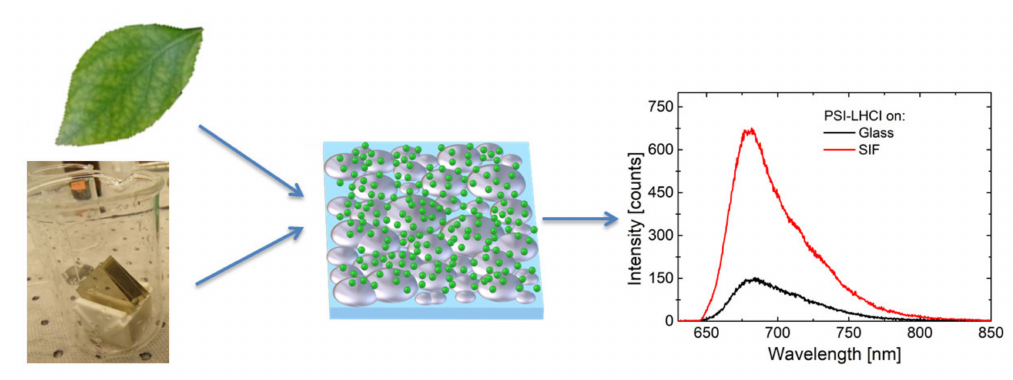
Figure 1. Schematic concept of a hybrid photosynthetic nanostructure and the e ff ect of plasmonic interactions between Silver Island Film (SIF) and photosynthetic